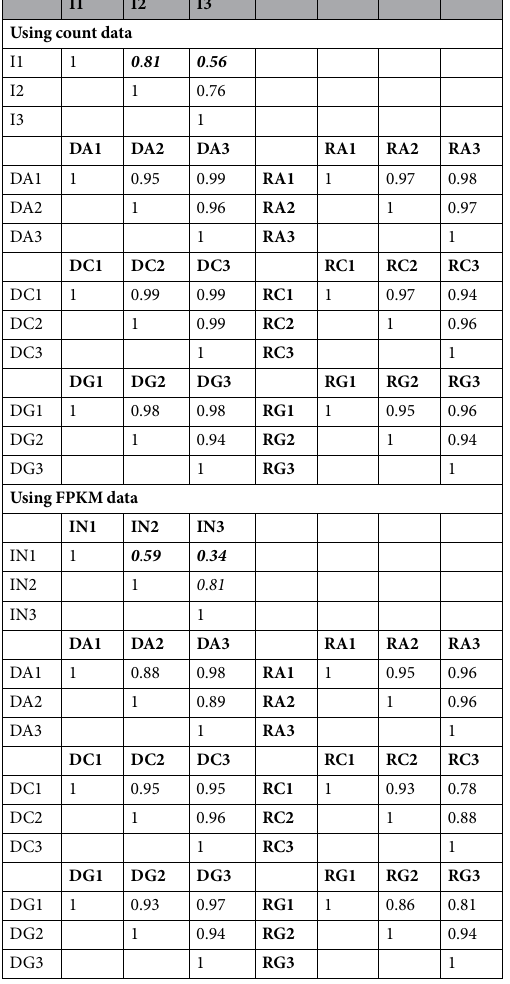
against the Swiss-Prot (SP) and TrEMBL (http://www.uniprot.org/downloads) databases (Table 4). This resulted in 12,066 (17.48%) and 11,788 (17.08%) transcript gene assignments, respectively, using 1e–5 as the e-value cutoff (Table 4). In addition to this direct CD-HIT-EST output search, open reading frames (ORFs) were generated from the start codon), 5,420 (8.2%) were 3 ′ -partial (missing a stop codon), and 4,535 (6.9%) were internal (lacking both a start and stop codon). These ORFs were also annotated via BLASTp against the SP and Uniprot-UniRef90 data- bases. These BLAST analyses resulted in a comparable level of transcript assignment: 10,993 (16.6%) and 10,778 (16.3%) predicted peptides/ORFs with significant hits, respectively (Table 4). In addition to the BLAST analyses, the ORF sequences were analyzed to identify predicted Pfam domains (HMMER/Pfam), transmembrane helices (TMHMM) and signal peptide cleavage sites (SignalP). All the outputs from BLASTx, BLASTp, HMMER/Pfam, TMHMM, and SignalP were combined into a single annotation file using Trinotate (Suppl. Figure 2 and Table 5).